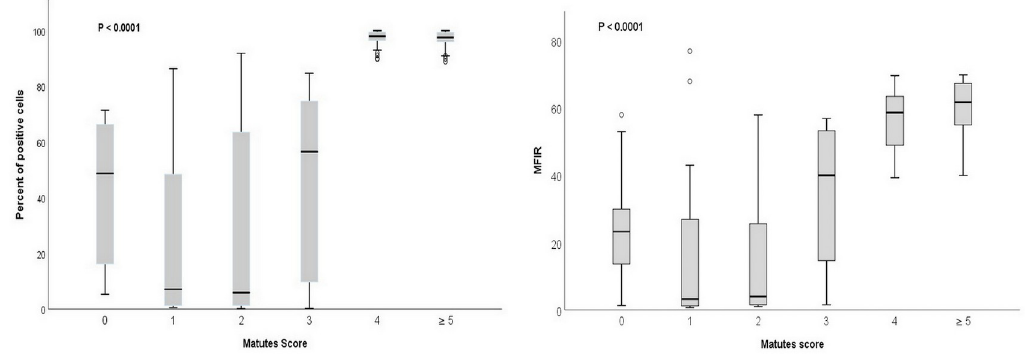
Fig 2. CD200 expression level on B-chronic lymphoproliferative disorders classified by Matutes score. (A) Shows median, minimum and maximum levels of CD200 percentage of expression. (B) Shows median, minimum and maximum levels MFIR of CD200.